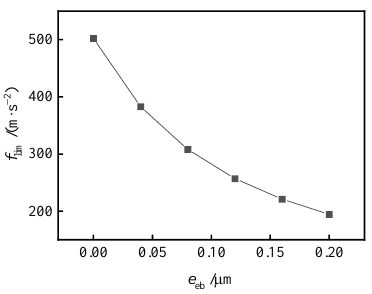
Figure 17. Overload limit versus eccentricity of the axis.